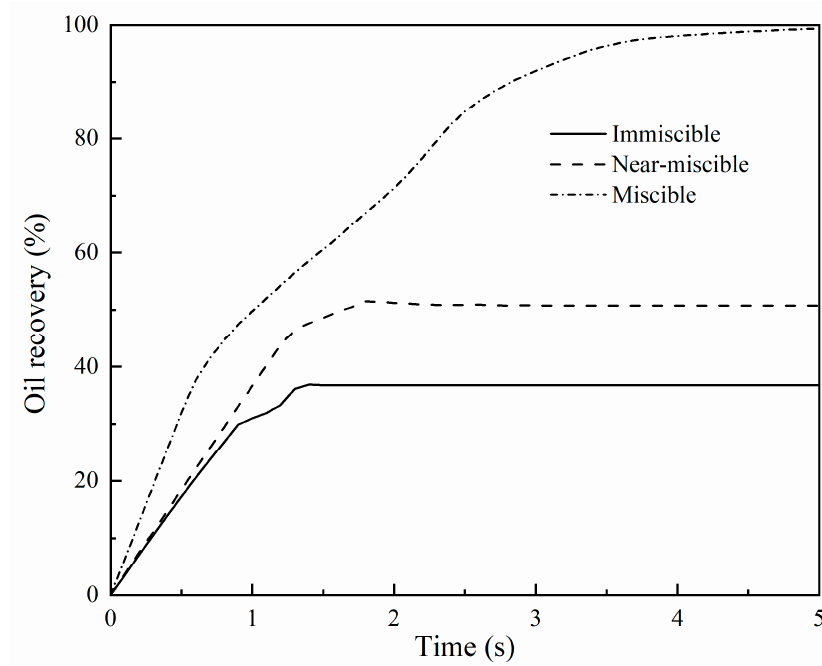
Figure 5. Oil recovery under immiscible, near-miscible, and miscible